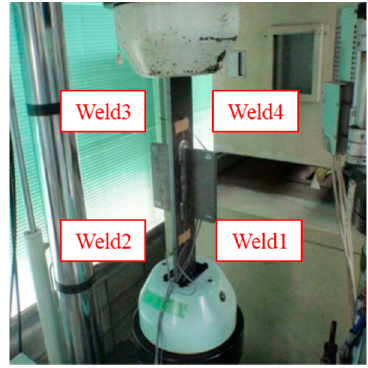
Figure 10. The experiment setup.